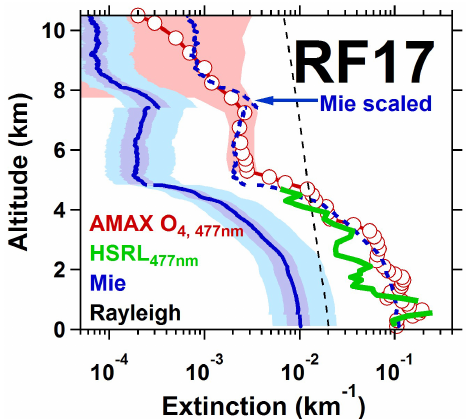
Figure 4. Comparison of measured and predicted O 4 SCDs for the two profile case studies. The lower panels show the relative dif- ference to the 1:1 line; solid lines represent the median bias and dashed lines the 1 σ standard deviation of scatter around the 1:1